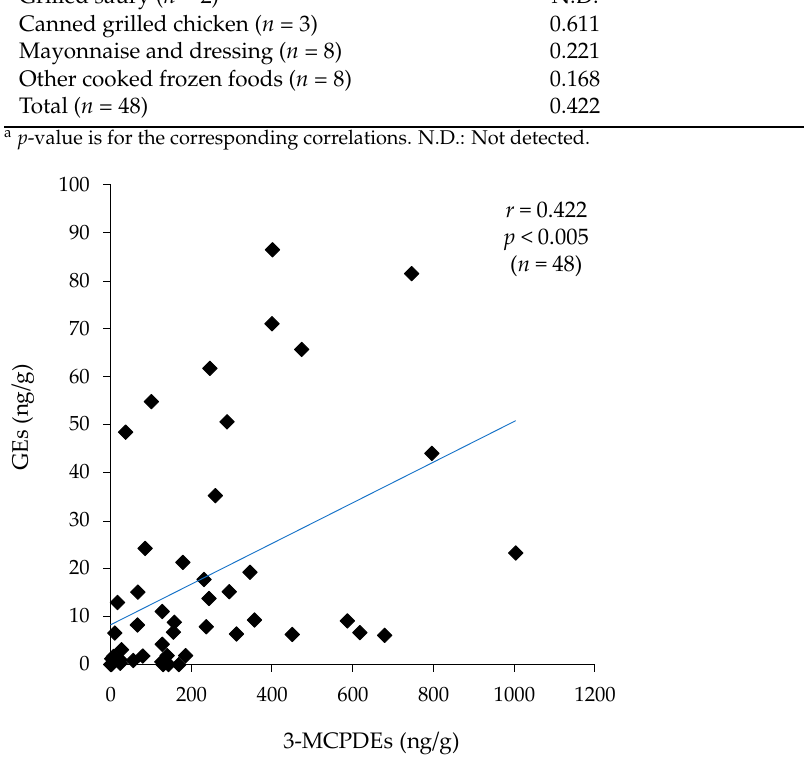
Table 4. Concentration of 3-MCPDEs in food samples from eight food categories.